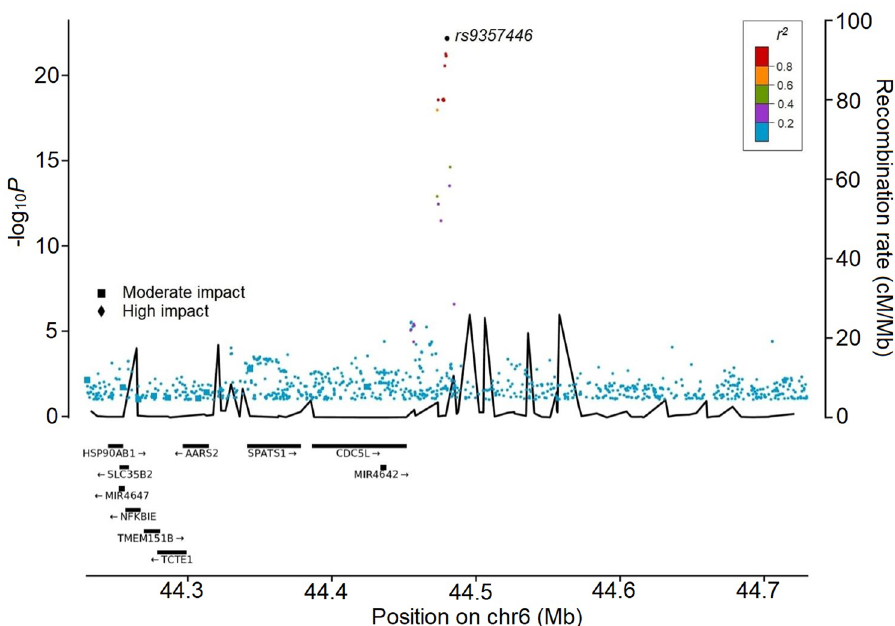
Figure 3. Regional visualization of the Bell’s palsy meta-analysis. The leading variant is colored in black. Other variants are colored by the degree of correlation ( r 2 ) with rs9357446. The − log 10 P -values on the left y-axis (two- sided logistic regression) are plotted for each variant against their chromosomal position (x-axis). The right y-axis shows calculated recombination rates based on the Icelandic data at the chromosomal location, plotted as solid black